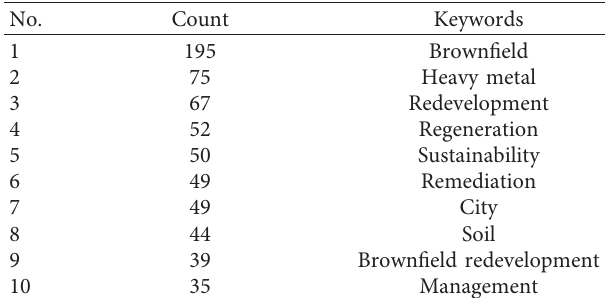
Figure 2: Number of publications on brownfield in the WOS core collection Table 1: Evolution trends of the top 10 keywords in brownfield research.